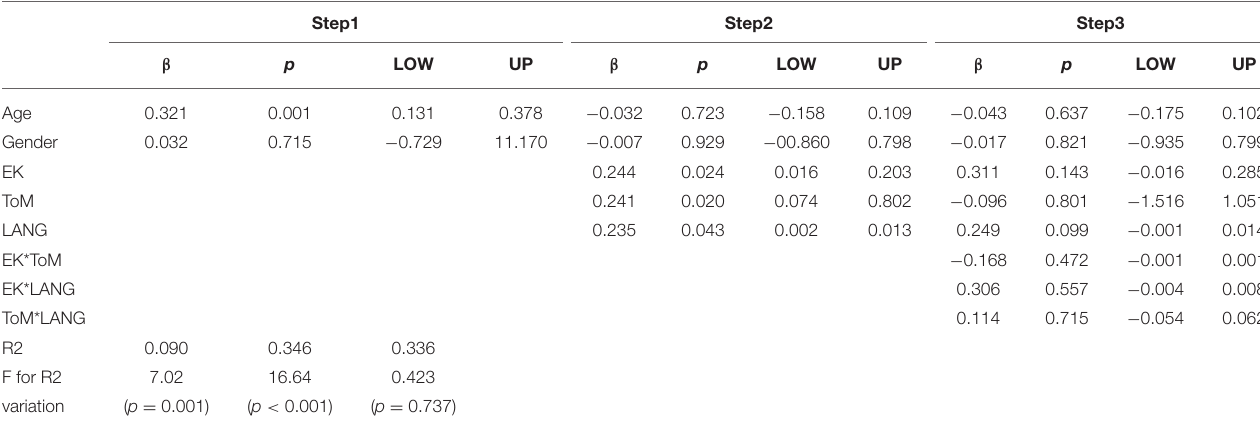
TABLE 2 | Results of regression analysis and coefficients of ToM, EK and LANG on prosocial behaviors.